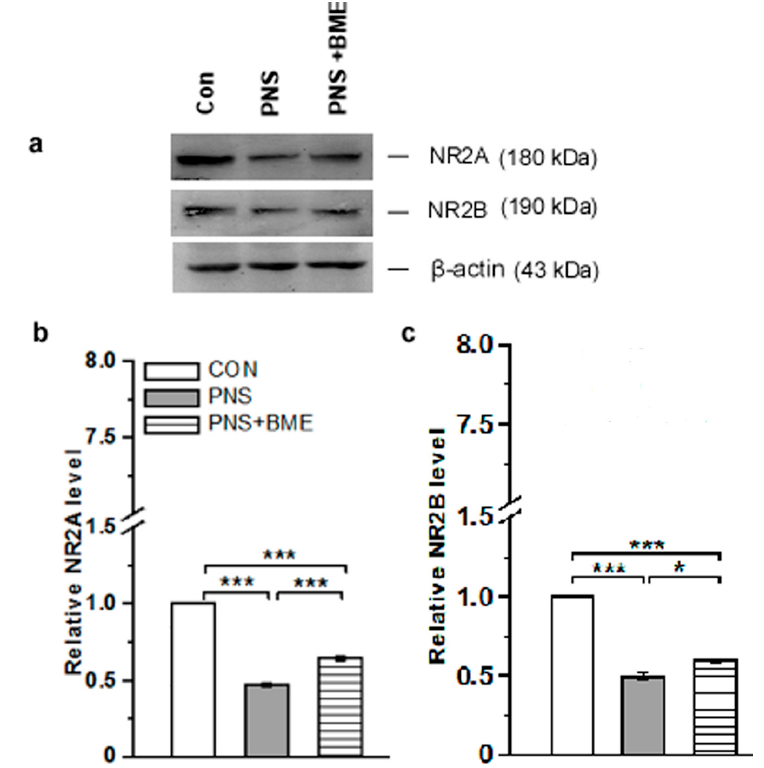
Figure 10. Exposure to BME treatment protects against the PNS-induced changes in NR2A and NR2B. ( a ) Representative Western blots showing that the level of NR2A and NR2B; ( b ) NR2A and ( c ) NR2B levels were significantly altered by exposure to BME treatment. Data are expressed as mean ± SEM ( n = 6 / each group). One-way ANOVA followed by Bonferroni post hoc test (for all pairwise multiple comparisons, statistical significance is indicated by * p < 0.05 and *** p <